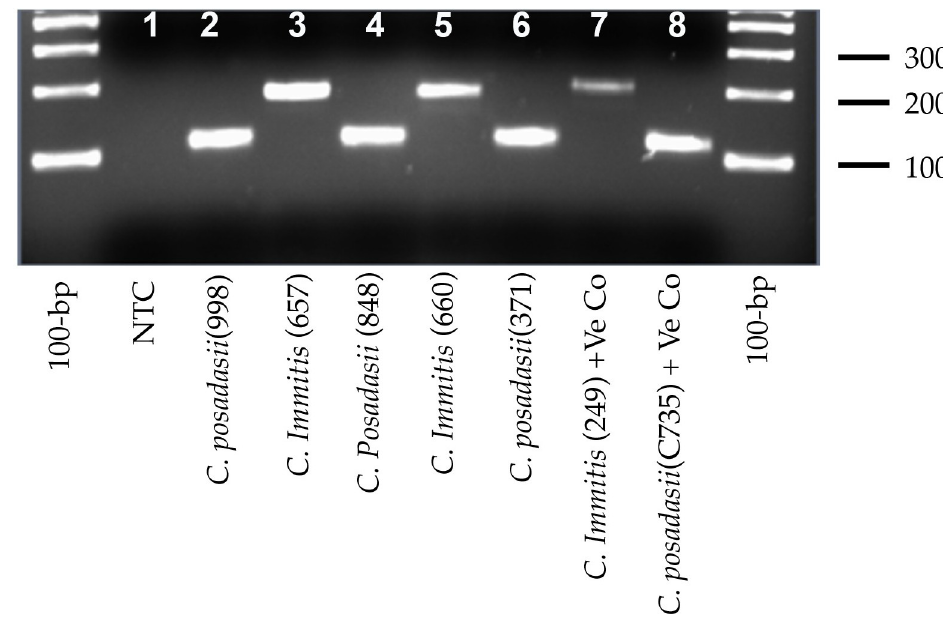
Fig 1. A modified conventional diagnostic PCR assay. A modification of assay described by Umeyama et al. (2006) allowed generation of smaller amplicons and better electrophoretic separation while maintaining test accuracy. First and last lane 100-bp DNA ladder; lane 1 non-template control (NTC), lanes 2, 4, 6, and 8 C . posadasii ; lanes 3, 5, and 7 C . immitis .